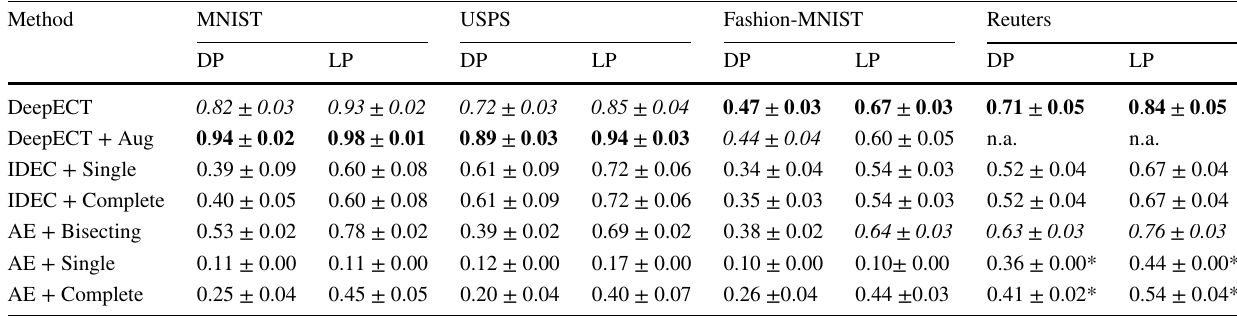
For results marked with a *, we had to use a random subset of the dataset with 100,000 objects and the same class distribution, because of memory limitations. The values are averages and the standard deviation for the ten pre-trained autoencoders. Best value in bold; runner up is